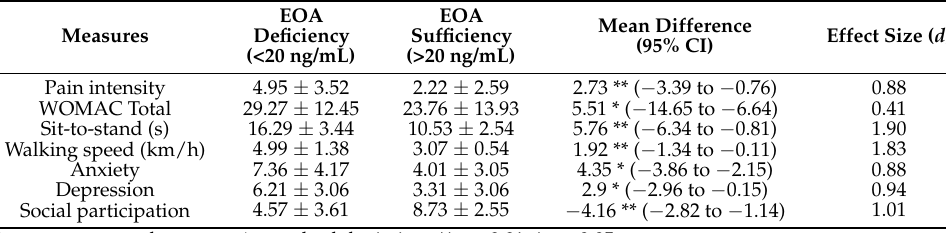
Table 3. Physical and psychological status in patients with EOA according to vitamin D